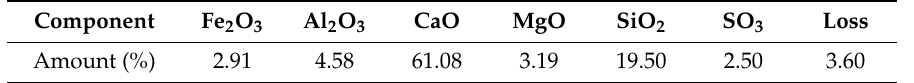
Table 1. Chemical properties of ordinary Portland cement.